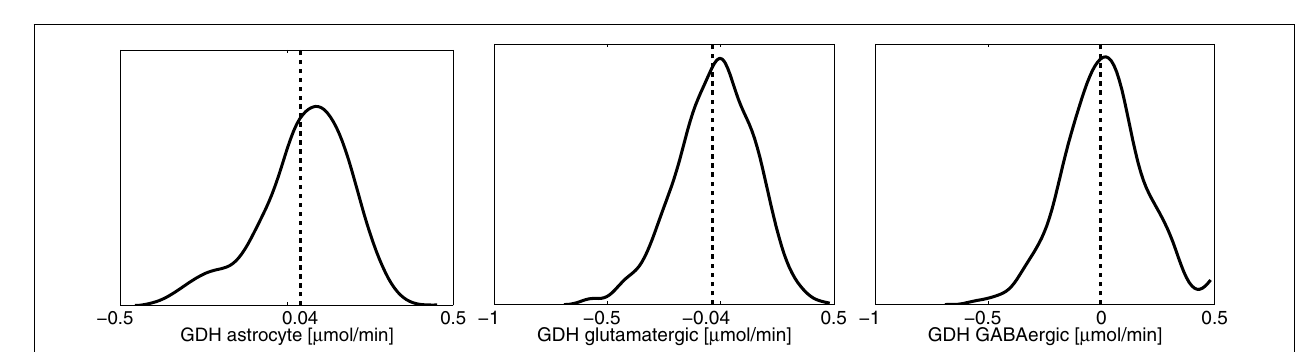
FIGURE 8 |The smoothed histograms of the GDH fluxes in each of the three cell types, calculated from the subsample of the flux vectors in which the NH + flux goes in the direction ECS → astrocyte .The sample mean in each cell is again indicated by the vertical 4